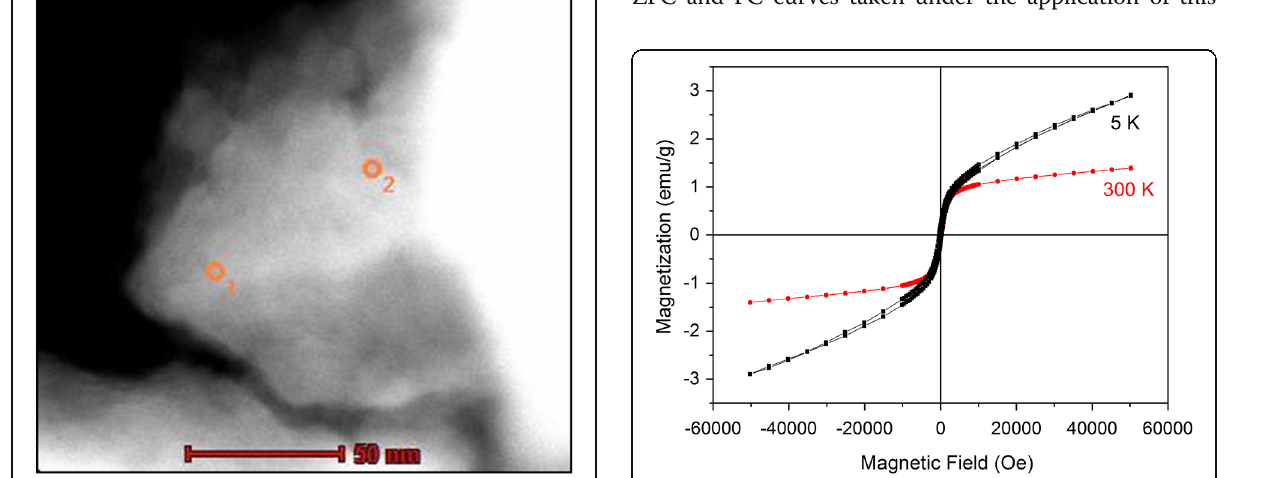
Fig. 10 Hysteresis loops of the CFTS sample taken at different